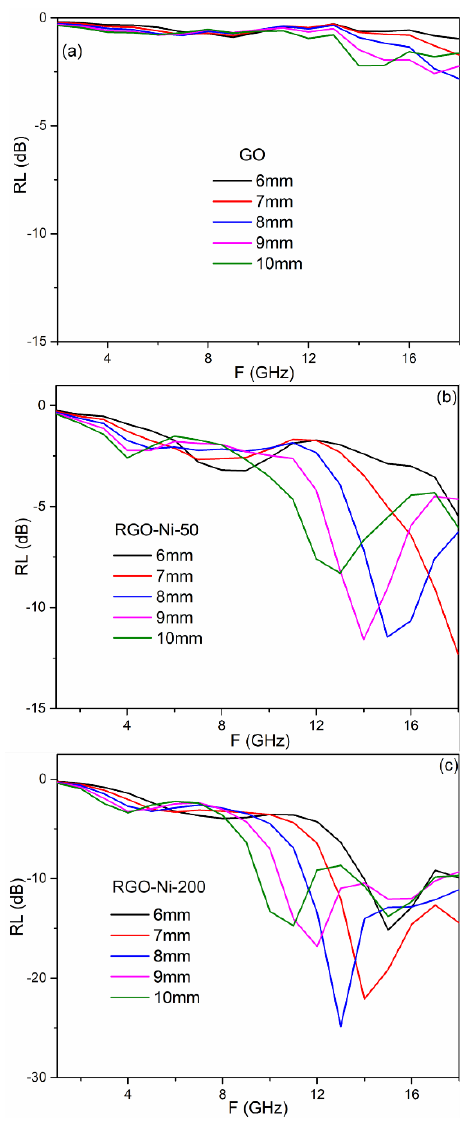
Figure 6. Calculated reflection loss (RL) curves of GO ( a ), RGO–Ni-50 ( b ), and RGO–Ni-200 ( c ) with different thicknesses vs. frequency within the range of 2–18 GHz.